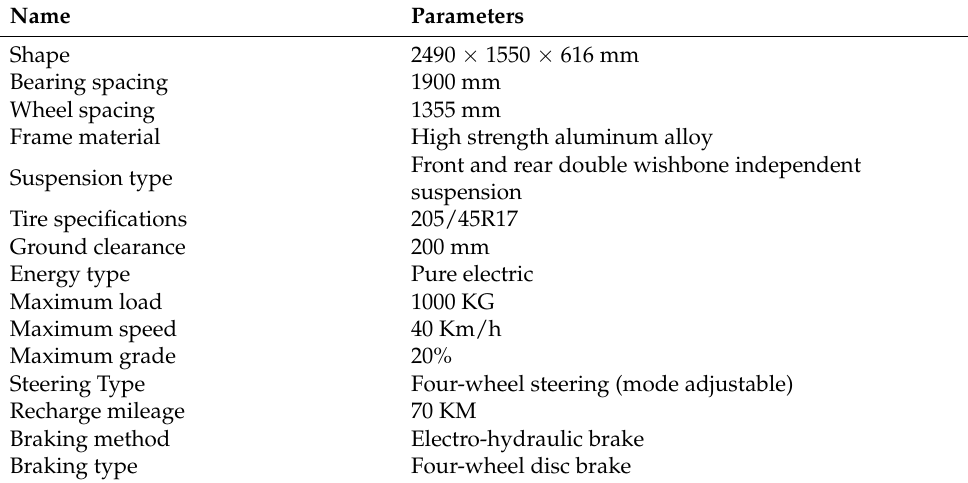
Table 1. Vehicle body structure parameters.